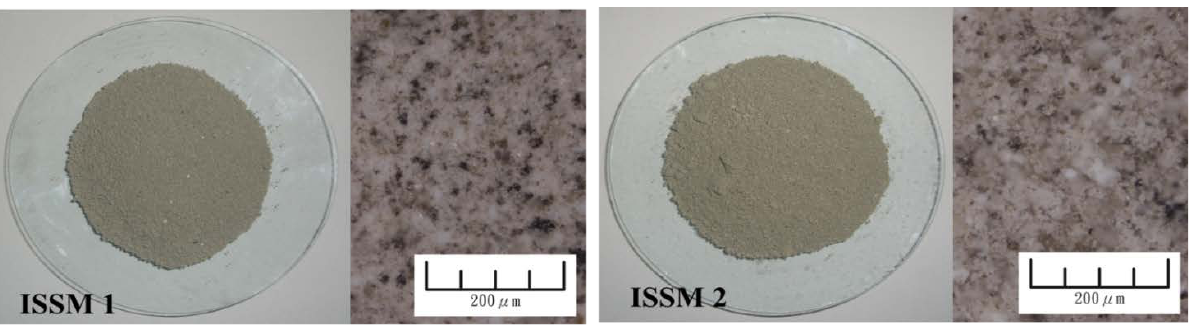
Figure 1. Inorganic Silicate Sealer Material.